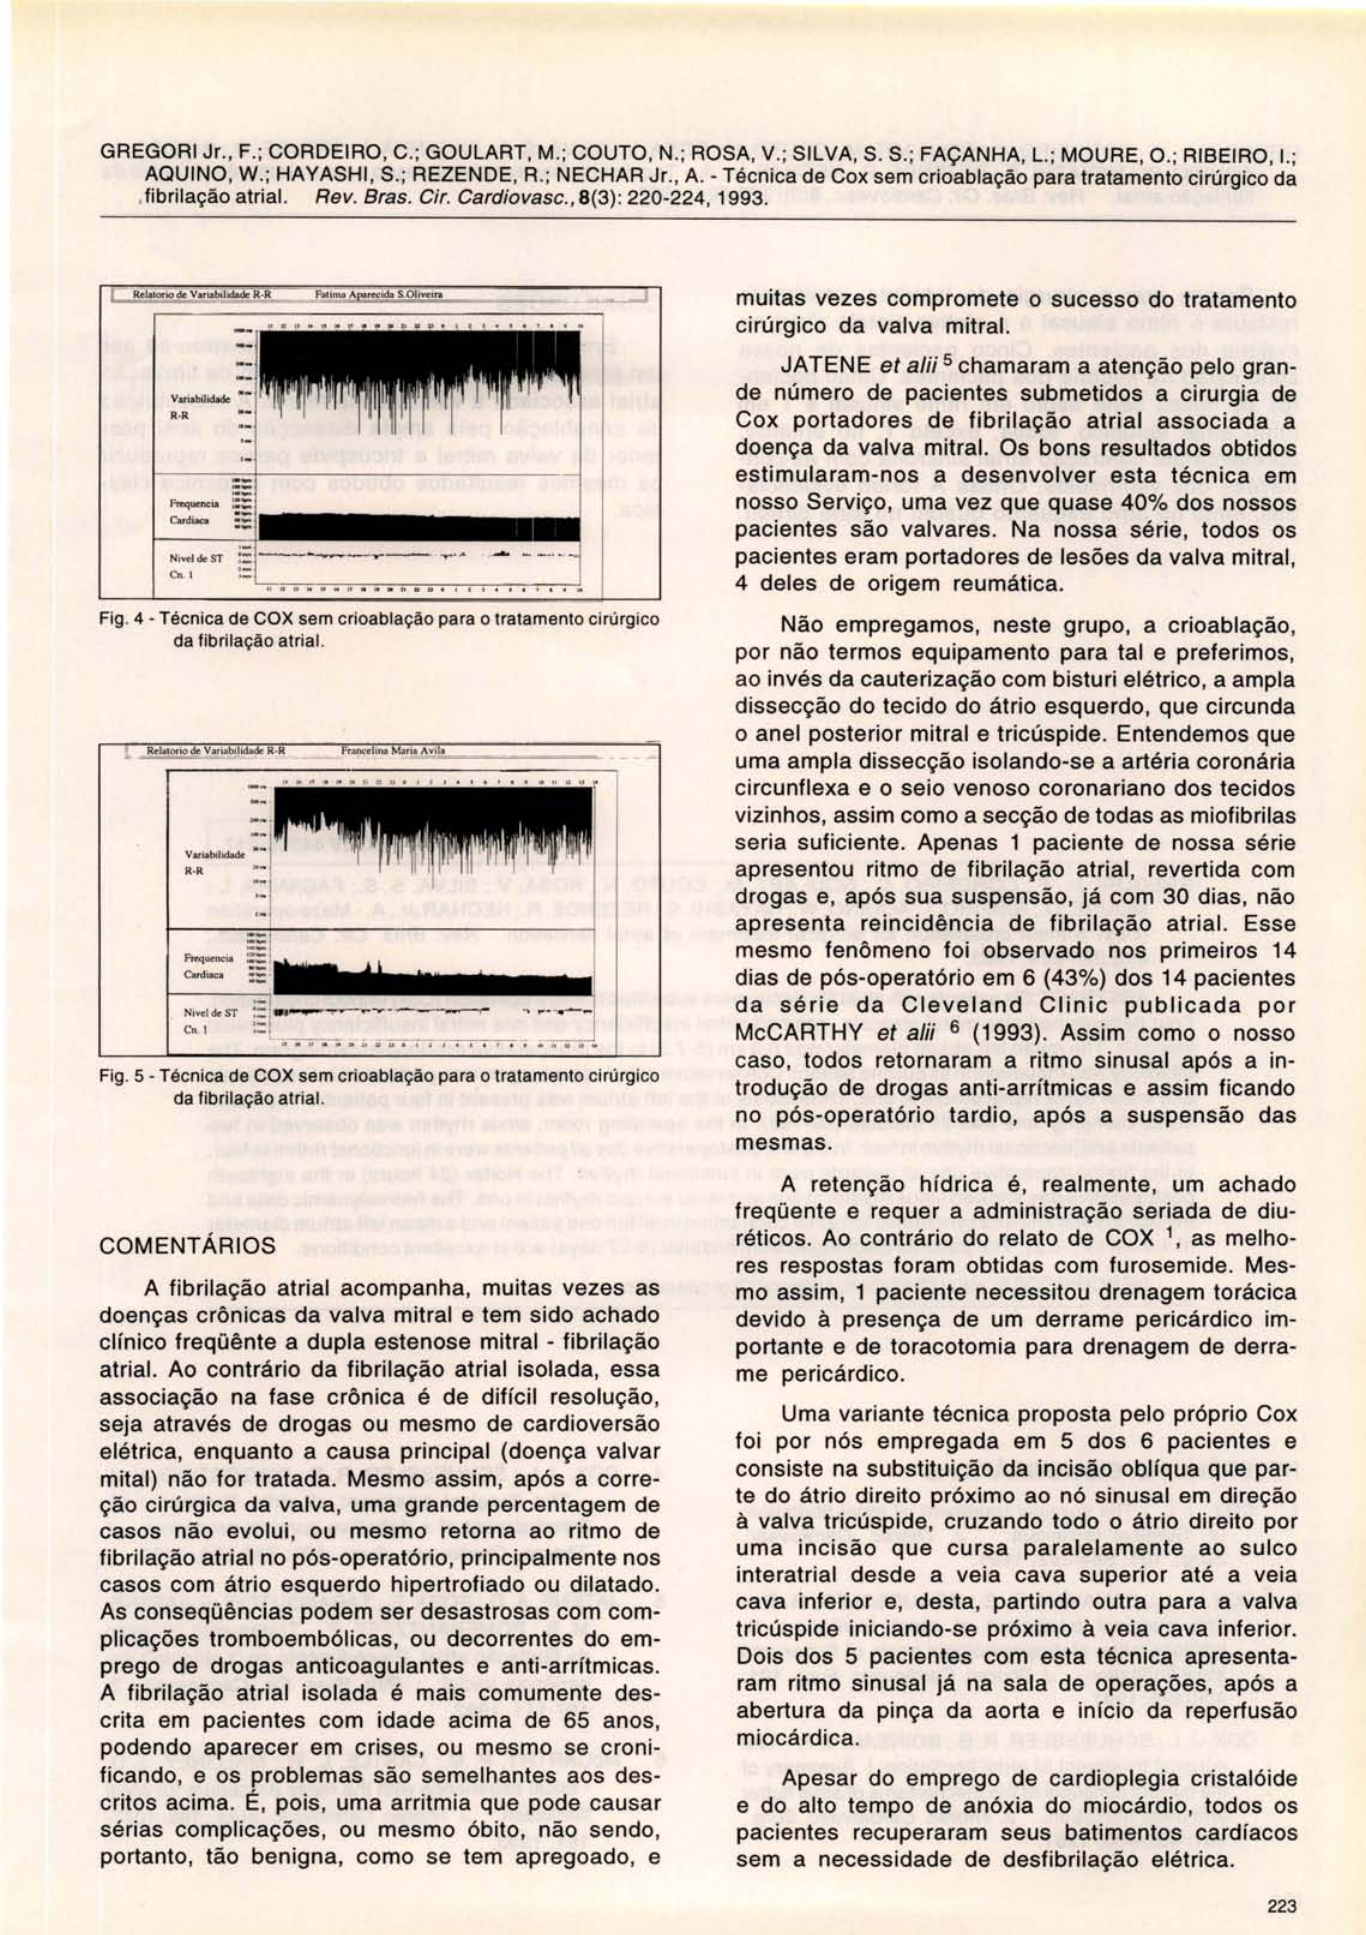
Fig. 4 - Técnica de COX sem crioablação para o tratamento cirúrgico da fibrilação atrial.